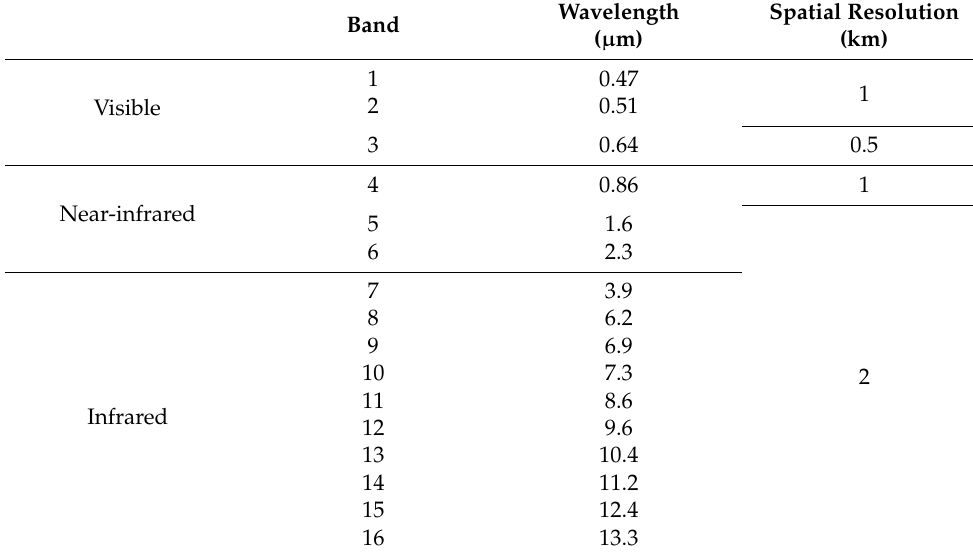
Table 1. The Himawari-8/AHI specifications.